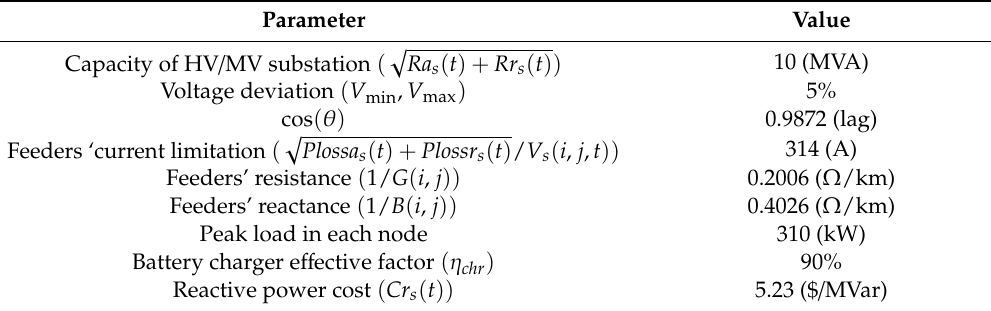
Table 2. Parameters of the Sample Network.